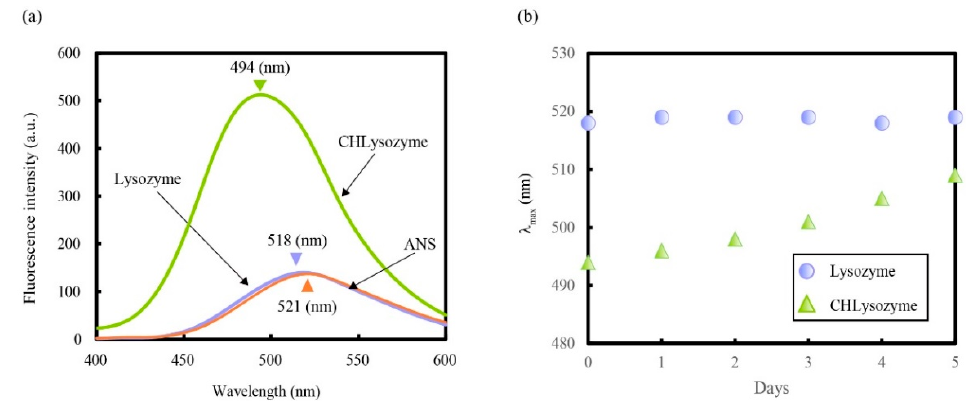
Figure 6. Fluorescence measurements of 8-anilinonaphthalene-1-sulfonic acid ammonium salt (ANS) alone and ANS with each lysozyme at 25 ◦ C. ( a ) Fluorescence emission spectra of ANS alone and ANS with lysozyme and CHLysozyme at 25 ◦ C. ANS concentration: 1.0 × 10 − 4 mol / L; lysozyme and CHLysozyme concentration: 0.2 mg / mL. Excitation wavelength: 365 nm. Gain value of fluorescence spectrometer: medium. ( b ) Change in λ max of ANS with lysozyme and CHLysozyme against time at 25 ◦ C. ANS concentration: 1.0 × 10 − 4 mol / L; lysozyme and CHLysozyme concentration: 0.2 mg / mL. Excitation wavelength: 365 nm. Gain value of fluorescence spectrometer: